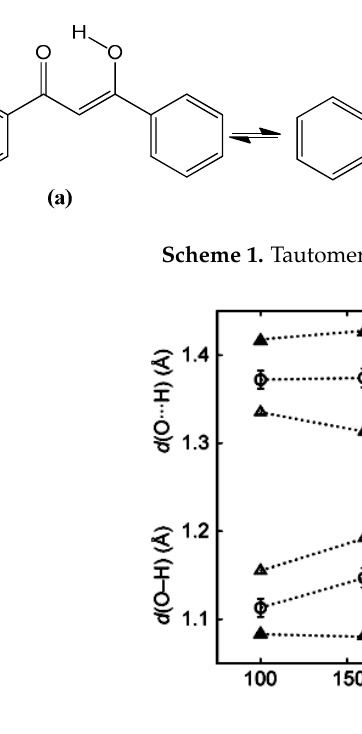
Figure 2. Neutron diffraction X–H bond length data compared both to X-ray-data (light gray circles) and quantum-chemically optimized values (purple circles). Values for X = C, N, O, S, B are given. Reprinted, with permission, from [24]. Copyright 2012, by The American Chemical Society.